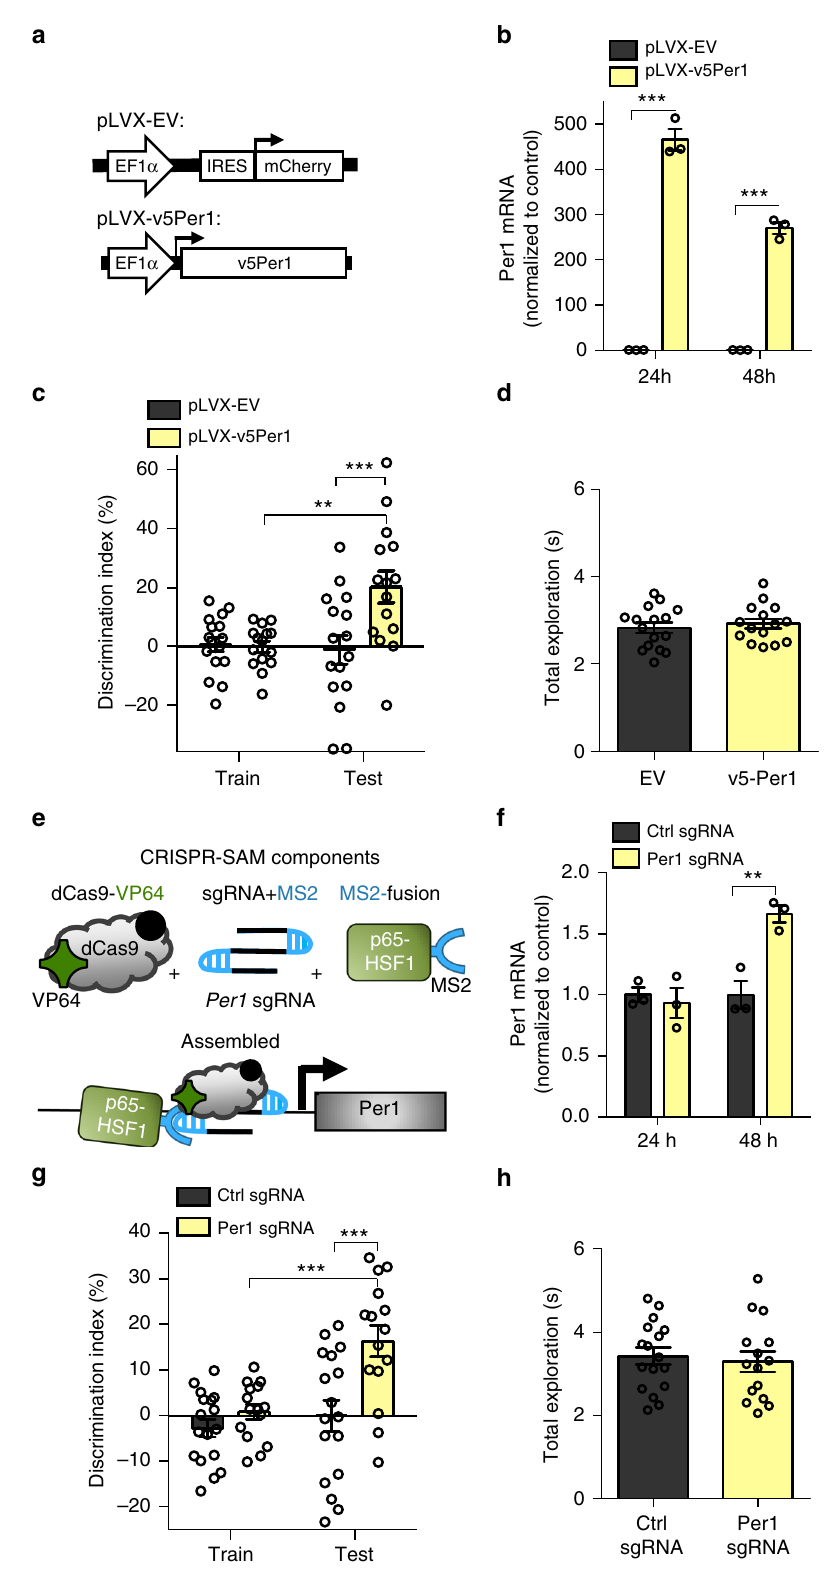
(Fig. 5e). Control animals received a control sgRNA lacking the 20 nucleotide sequence required to target the SAM system to Per1 (referred to as ctrl sgRNA). Assembly of these components at the Per1 promoter allows the three effector domains (VP64, p65, and HSF1) to drive Per1 transcription. To con fi rm the effectiveness